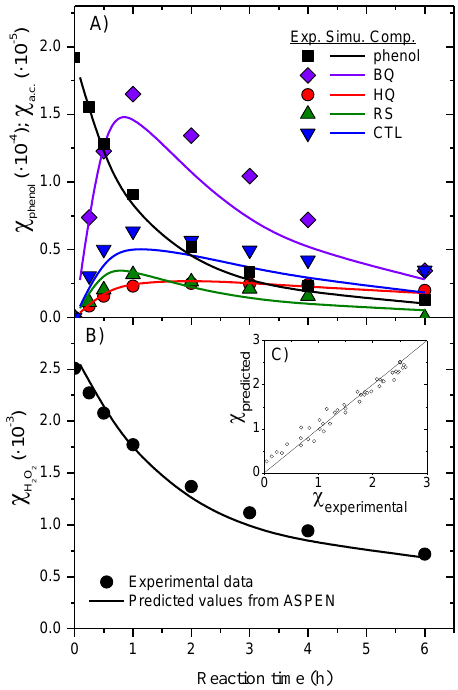
Figure 2. Experimental results (symbols) and those predicted by the ASPEN Plus® v11 simulator (curves) time course of the molar fraction of aromatic compounds ( A ) and H 2 O 2 ( B ) in a batch reactor at C Phenol,0 = 1 g L −1 , C H = 5 g L −1 , W = 4 g cat , pH 0 = 6 and T = 90 °C . Inset: parity plot of H 2 O 2 molar fraction.